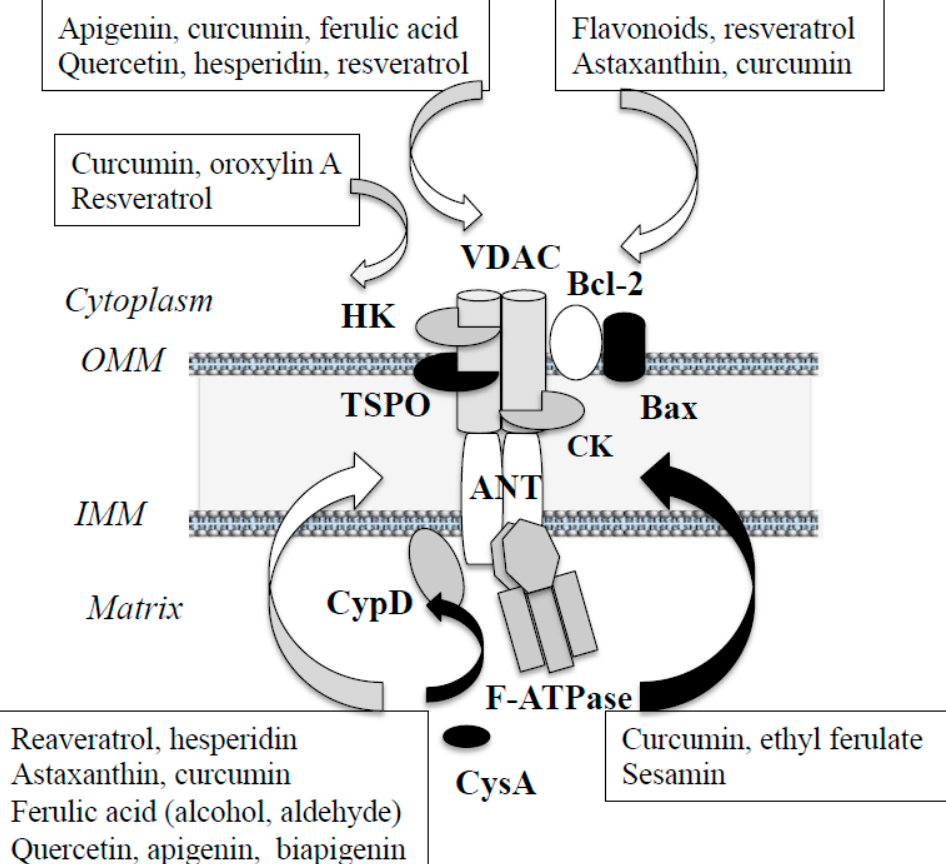
Figure 1. Schematic structure of the mitochondrial permeability transition pore (mPTP) and e ff ects of phytochemicals on the mPTP components. Voltage-dependent anion channel (VDAC) and adenine nucleotide translocator (ANT) are considered as major mPTP components. The outer membrane transporter protein (18 kDa) (TSPO) interacts with the mPTP at the outer mitochondrial membrane (OMM), hexokinase (HK) from cytoplasm, creatine kinase (CK) at the intermembrane space, and cyclophilin D (CypD) interacts with ANT from the mitochondrial matrix. But it has not been established whether they are absolutely required as the pore constituents. F 1 -F 0 ATP synthase (F-ATPase) binds to CypD and the c subunit ring of the F 0 domain is included into the pore-forming unit of the mPTP. CypD binds to ANT at the IMM and induces the membrane permeability transition (MPT) at the IMM, which cyclosporine A (CysA) inhibits. Anti-apoptotic Bcl-2 proteins located at the OMM inhibit the mPTP opening. Phytochemicals interact with the mPTP components either in a suppressive or promoting way, as shown by white or black arrows. White and black arrows indicate promoting and inhibiting e ff ects, respectively.